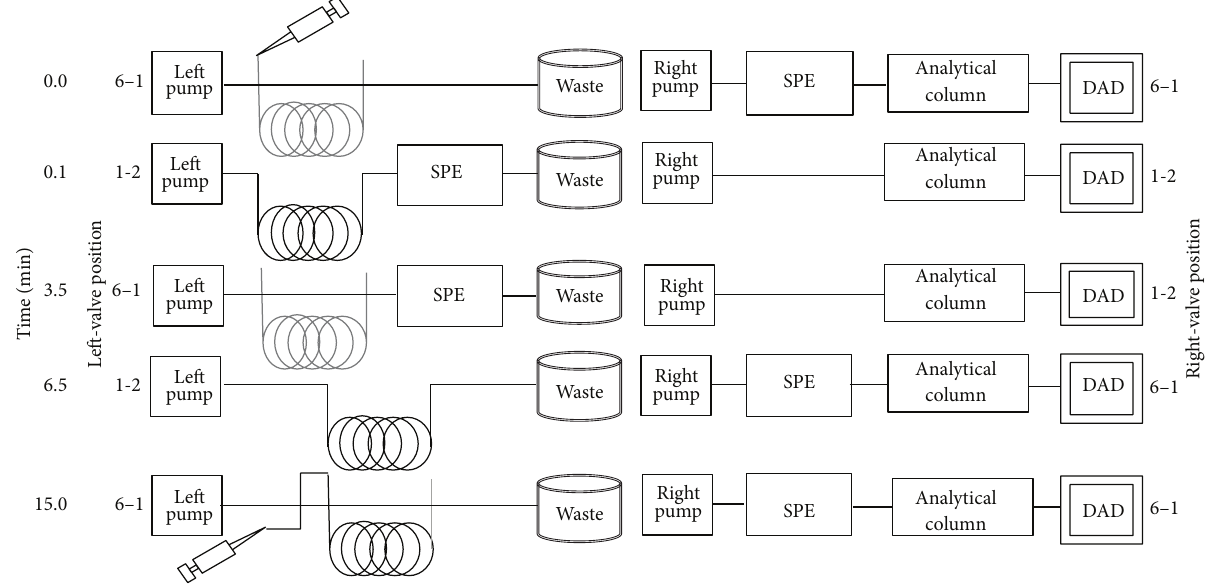
Figure 2: Schematic diagram of column switching during loading and enrichment